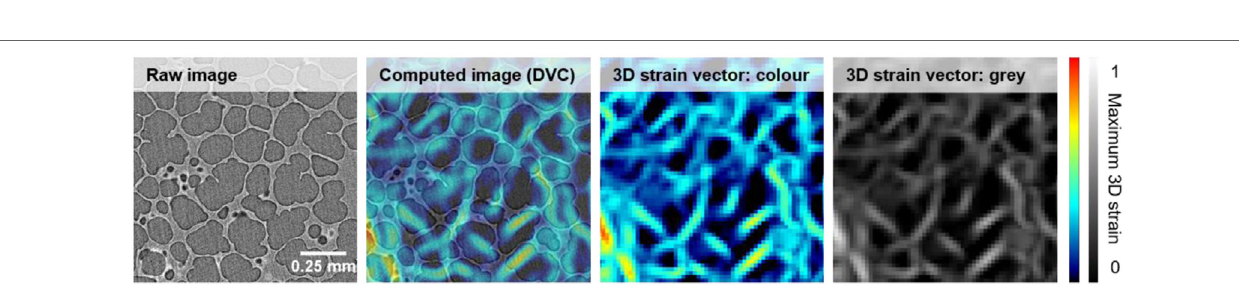
FigUre 4 | Volume correlation process applied to a control sample. Images show the steps from a raw volume image to the extracted maximum three-dimensional strain